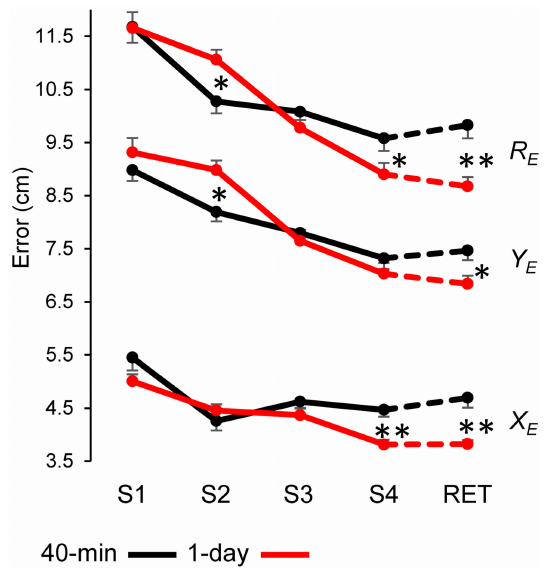
Figure 2. Learning time course over training and retention sessions. Changes in performance are represented as radial error ( R E ), medial-lateral error ( X E ) and anterior-posterior error ( Y E , throwing axis). Each point represents the grand average ± standard error over the subjects calculated for session 1–4 (S1, S2, S3, S4) and retention session (RET) and for each group (40-min group, black lines;